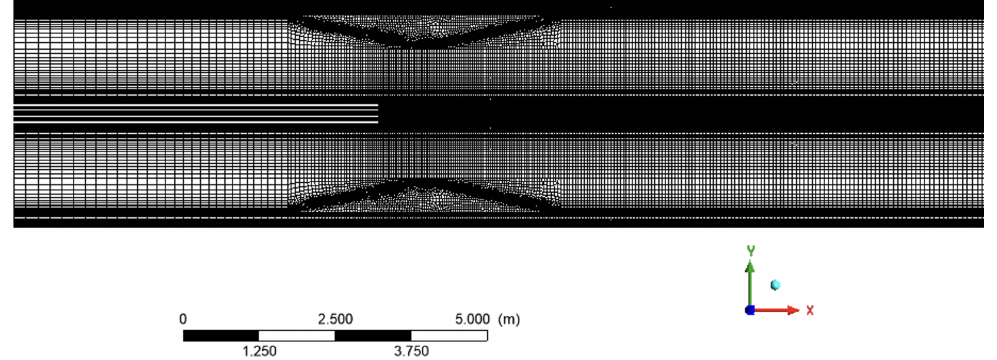
Figure 2. Mesh near the burner and dam of the